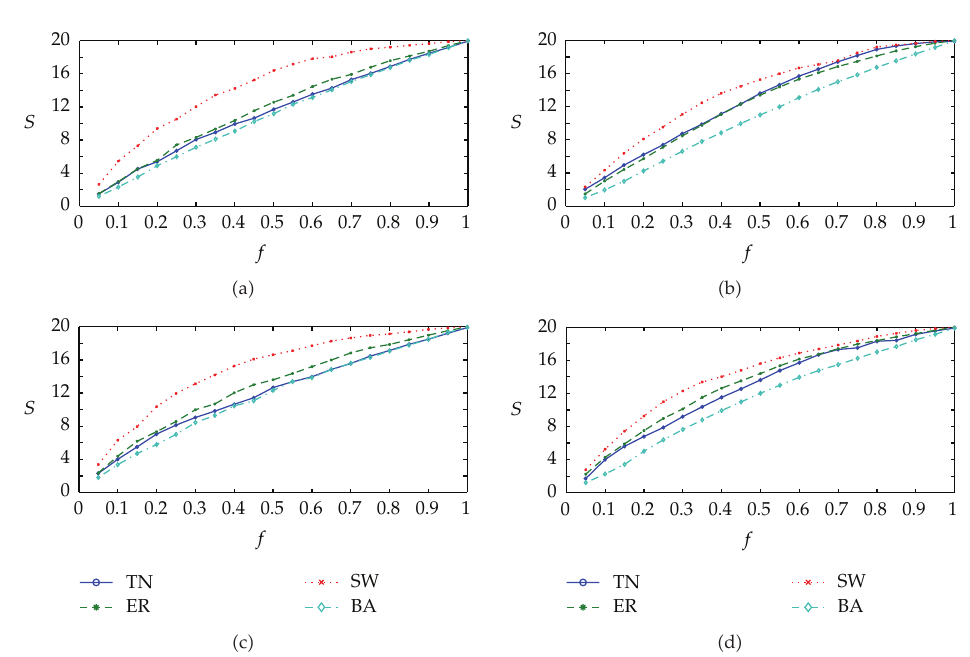
Figure 3: Di ff erences of shocks on four types of networks. TN, ER, SW, and BA represent, respectively, the tiered networks, random networks, small-world networks, and scale-free networks. (cid:5) a (cid:6) and (cid:5) b (cid:6) are the respective results of random shocks and selective shocks in the homogeneous case, (cid:5) c (cid:6) and (cid:5) d (cid:6) random shocks and selective shocks in the heterogeneous